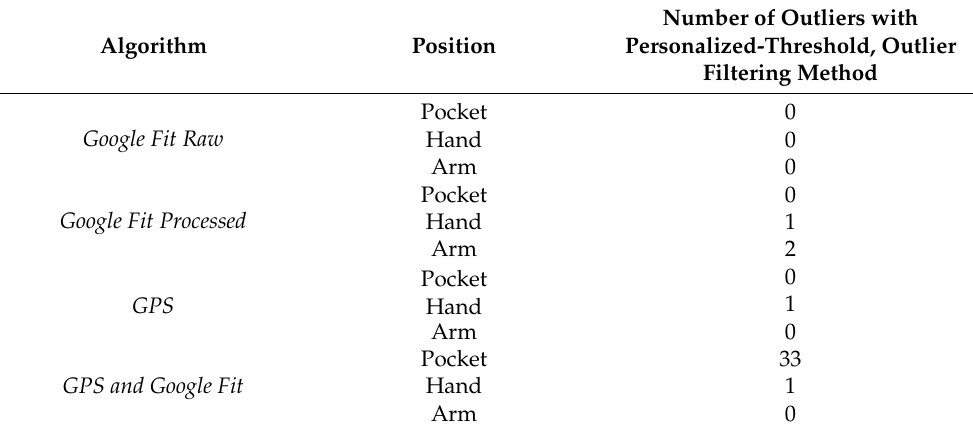
Table 4. Number of missing values and number of outliers for each combination of algorithm– smartphone position for the smartphone-measured, random walk six-minute walk test. Algorithm Position